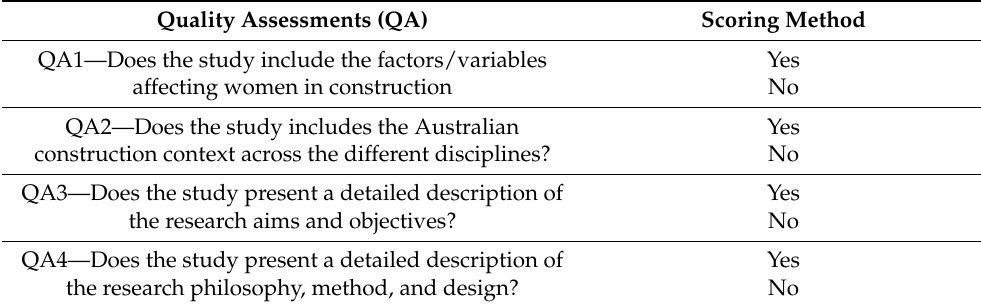
Table 1. Quality Assessment